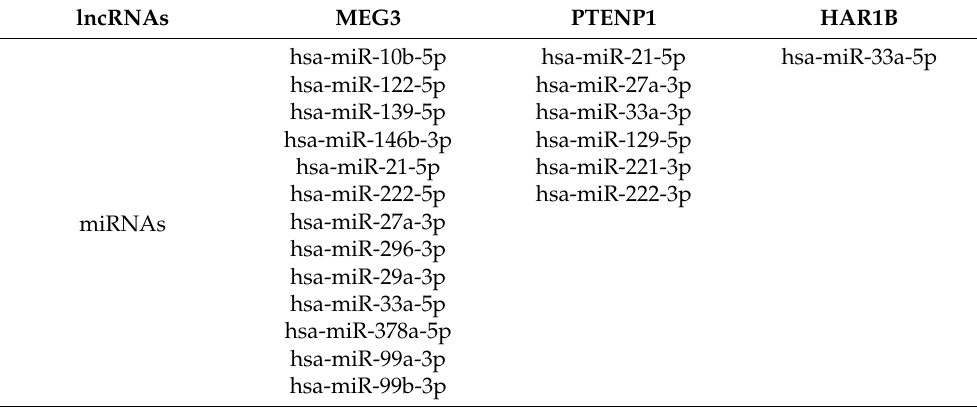
Table 4. Distribution of miRNAs associated with lncRNA with DIANA lncBase v3.0 online soft- ware.